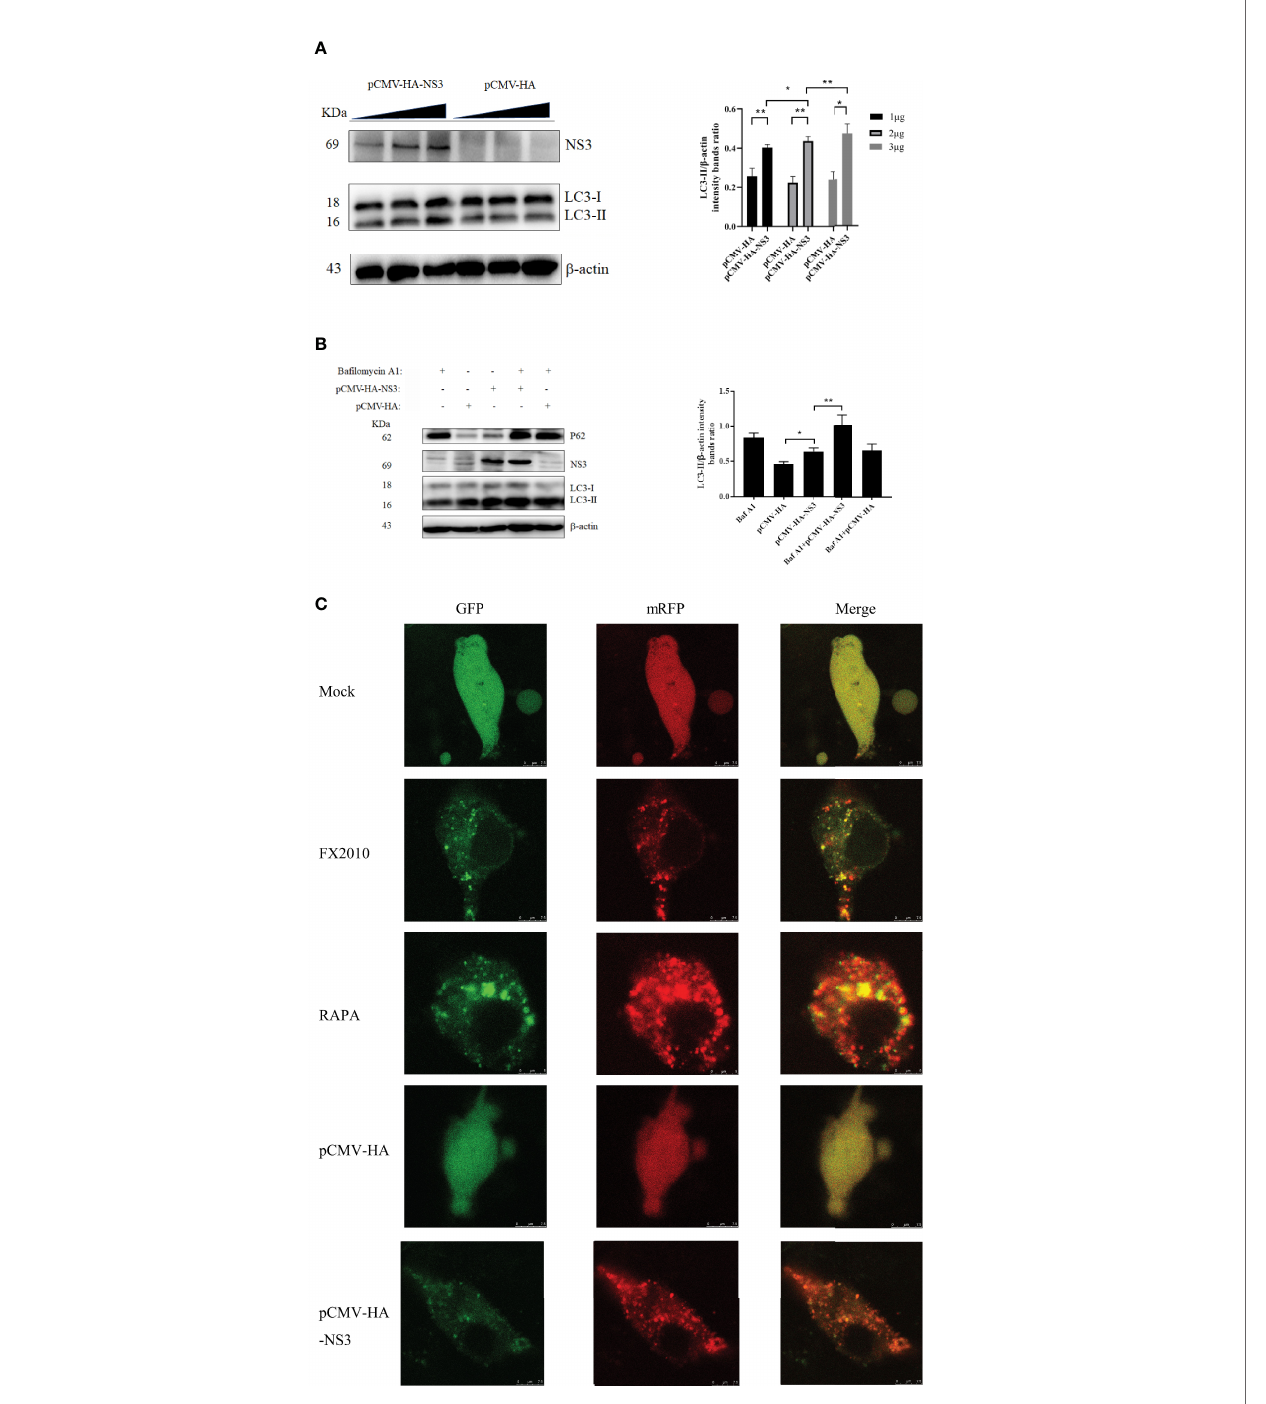
FIGURE 2 | NS3 can cause complete autophagy fl ux. (A) The amount of NS3 or pCMV-HA plasmids transfected into each six-well plate cells was 1 mg, 2 mg, and 3 mg, respectively. Samples were harvested at 24 hpt for Western blot analysis. (B) After 24 h of treatment with Ba fi lomycin A1 (400 nM), the pCMV-HA and pCMV- HA-NS3 plasmids were transfected into DEF cells respectively, and samples were collected at 24 hpt. (C) DEF cells were transfected with mRFP-GFP-LC3 plasmids for 24 h. Then proceed to the following processing group. DEF cells were transfected with pCMV-HA and pCMV-HA-NS3 plasmids respectively or treated by RAPA (5 m M) for 4 h as positive control or infected with MOI = 1 virus for 24 h. All the samples were collected and observed by electron microscope. The density of the protein bands measured with fusion analysis in ImageJ software was determined after subtracting the density of the b -actin bands. The b -actin protein was used as the internal control. Data (M ± SD of technical triplicates) represent three independent experiments or are pooled from three independent experiments (M ± SD). * p < 0. 05; ** p < 0.